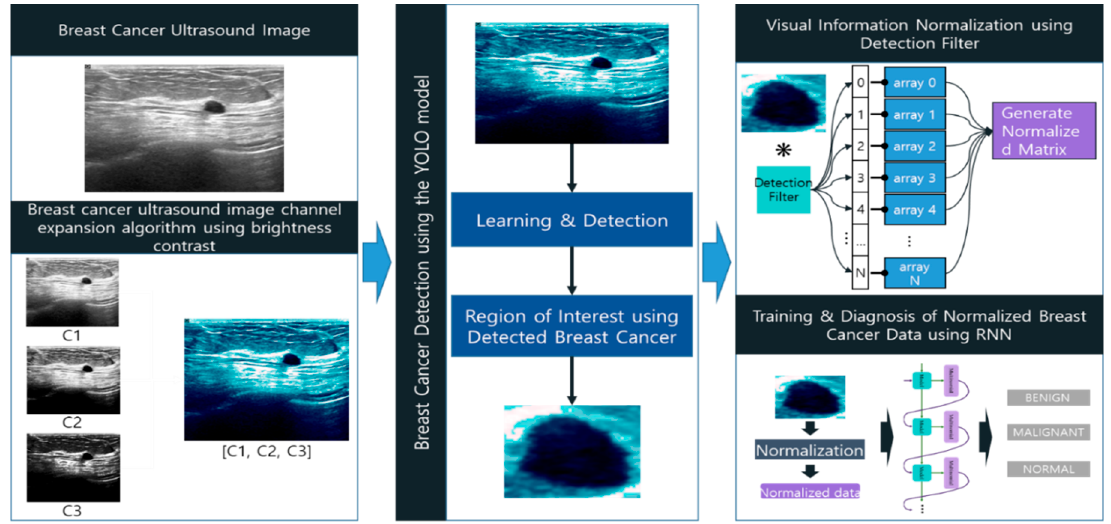
Figure 8. Breast cancer diagnosis model through normalized pattern transformation using RNN-based visual information.